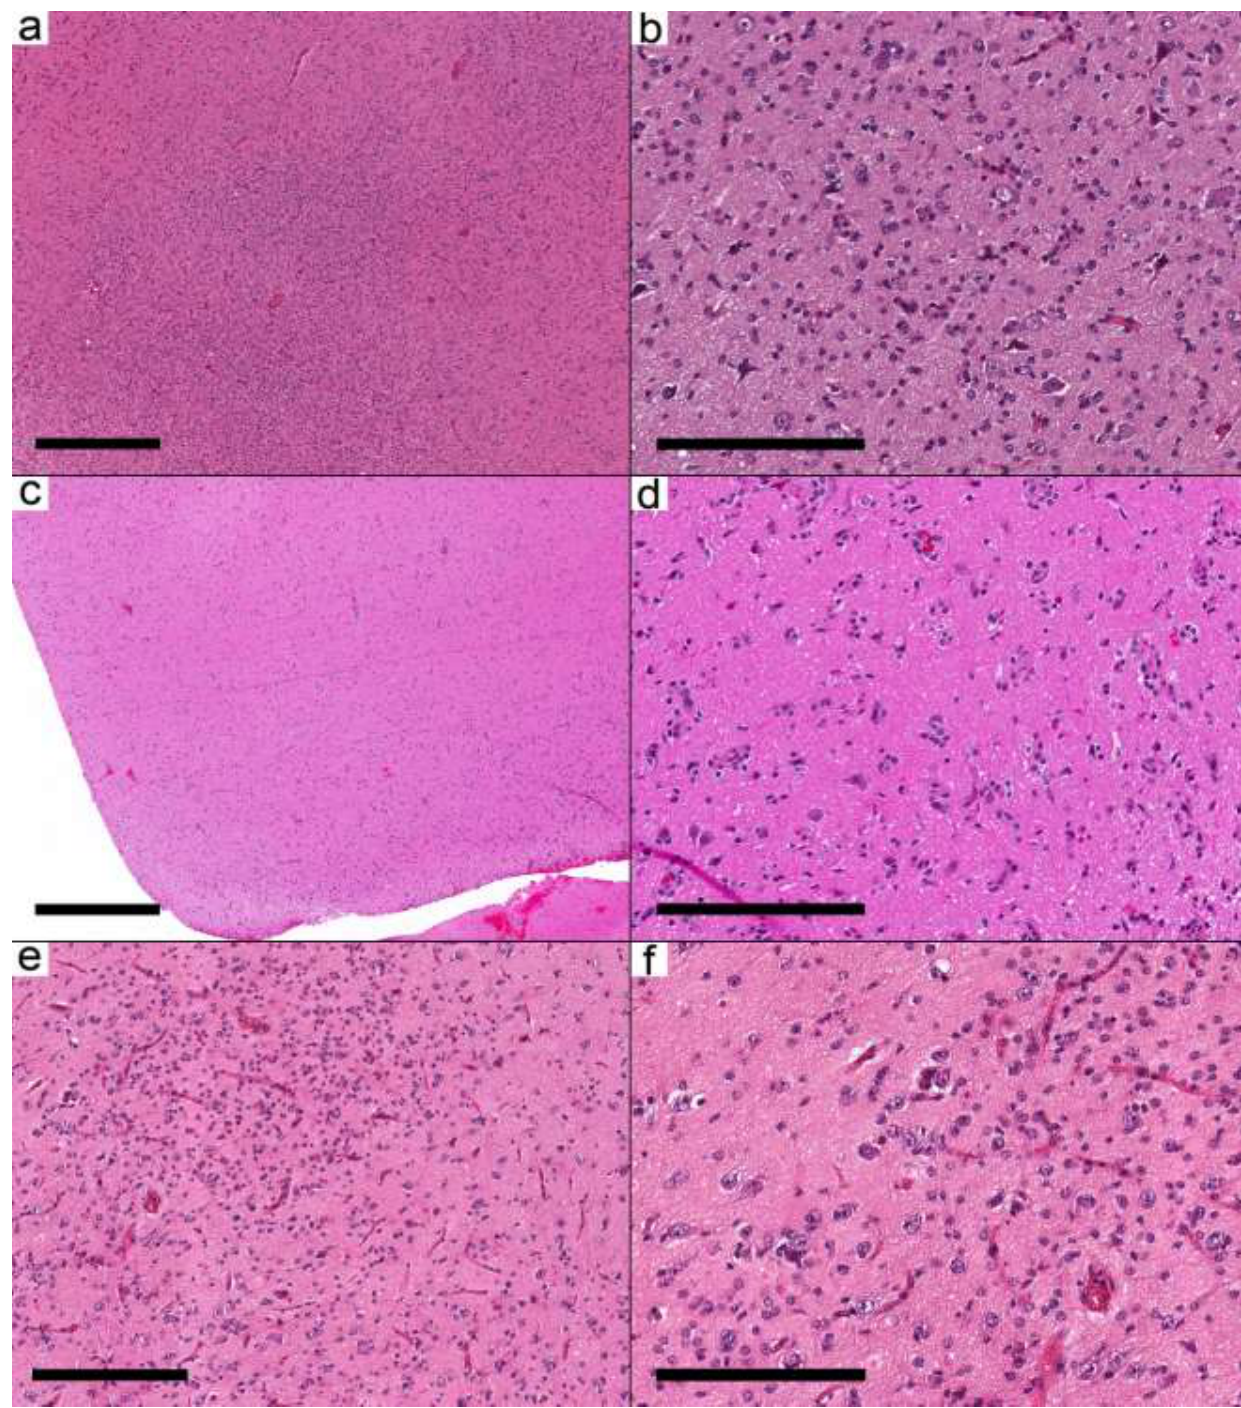
Figure 2. Ganglioglioma with predominant infiltrative pattern. ( a – e ) Three different cases show similar morphological features. ( a , c , e ) The cortical areas are involved by a low-moderately cellular neoplasm formed by dysmorphic neurons and oligodendrocyte-like cells. ( b , d , f ) Oligodendrocyte- like cells are arranged around neurons and blood vessels resembling infiltrative glioma. Cases: ( a , b ) Case 8; ( c , d ) Case 9; ( e , f ) Case 10. Scale bars: 600 µm ( a , c ); 200 µm ( b , d , f ); 300 µm ( e ).